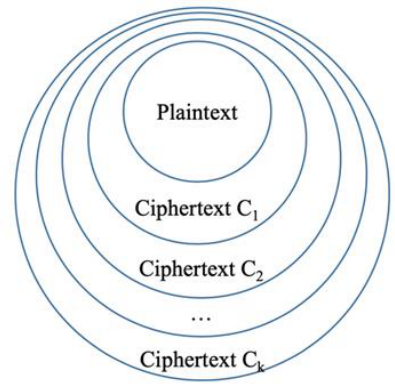
Figure 8. Ciphertext that is encrypted with k public keys.